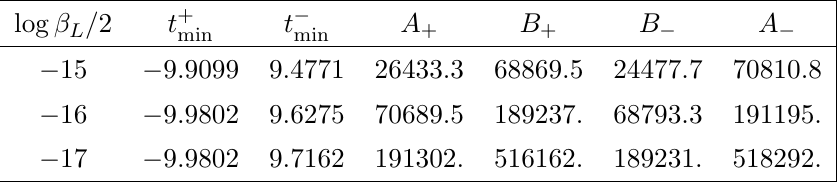
Table 1 . Excess areas of the interaction peaks of the spectral densities A (cid:6) compared to the areas